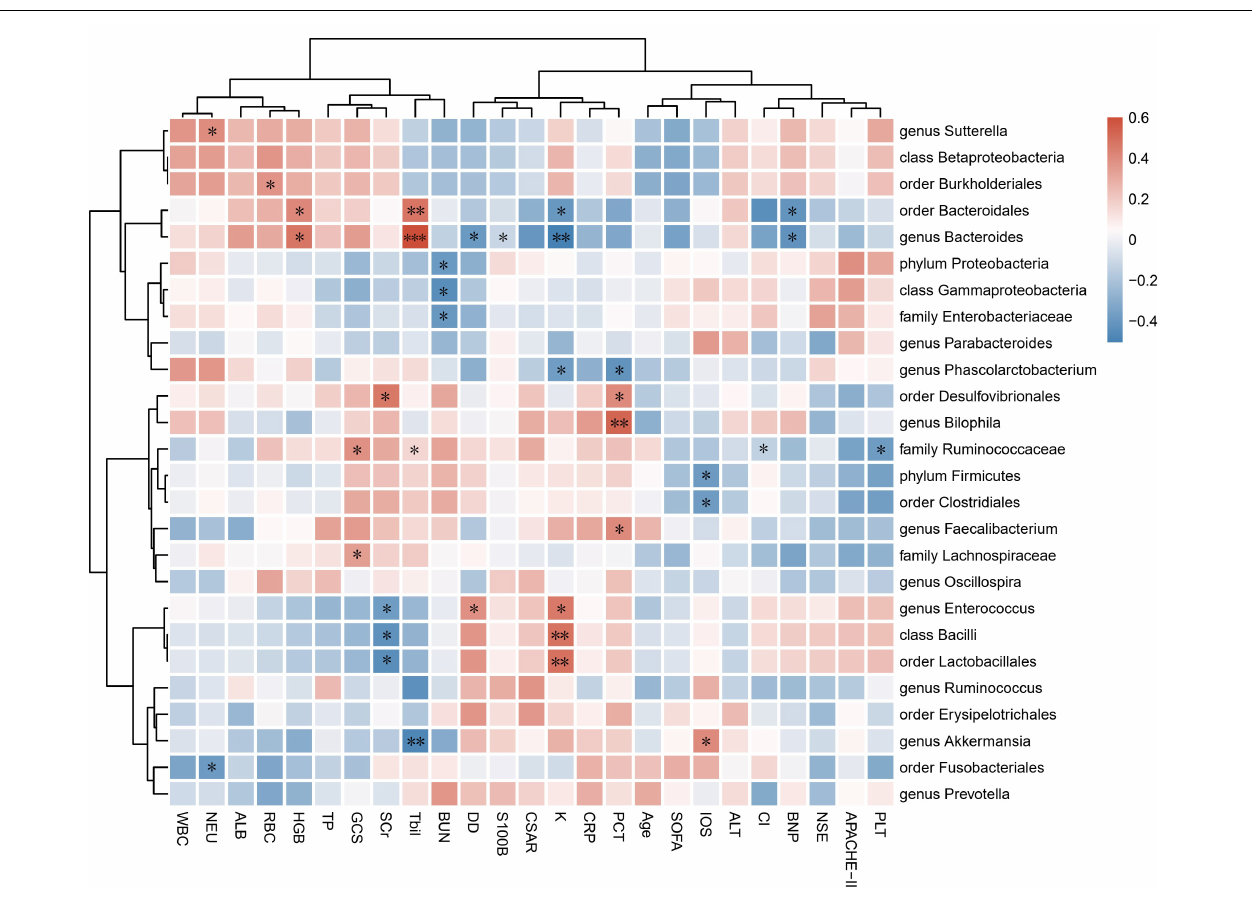
FIGURE 2 | Associations of gut microbial taxa with clinical indexes. Heat map of Spearman’s rank correlation coefficient among 17 clinical indexes and 26 taxa with abundances higher than 0.1%. n = 28; ∗ p < 0.05; ∗∗ p < 0.01; ∗∗∗ p < 0.001; Spearman’s rank correlation. WBC, white blood cell count; NEU, neutrophil count; RBC, red blood cell count; HGB, hemoglobin; PLT, platelet count; ALT, alanine aminotransferase; Tbil, total bilirubin; TP, total protein; ALB, albumin; Cl, serum chlorine, K, serum potassium; BUN, blood urea nitrogen; SCr, serum creatinine; CRP, C-reactive protein; PCT, procalcitonin; DD, D-dimer; BNP, brain natriuretic peptide; NSE, neuron-specific enolase; S100B, S100 calcium-binding protein B; CSAR, cerebrospinal fluid albumin-to-serum albumin ratio; GCS, Glasgow Coma Scale; SOFA, Sequential Organ Failure Assessment; APACHE-II, Acute Physiology and Chronic Health Evaluation-II; IOS, length of stay in the ICU.